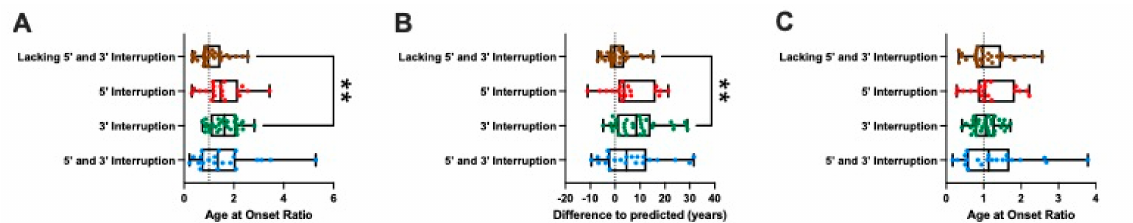
Figure 5. Interruption at the 3 (cid:48) end of the FXN GAA repeat tract is associated with a delayed age at disease onset. ( A ) Box-and-whisker plot showing the age at onset ratio (Actual/Predicted) when using the model of the subgroup lacking interruptions to predict age at onset for all members of the cohort. Kruskal–Wallis and subsequent Dunn’s multiple comparisons tests show that the 3 (cid:48) interruption subgroup had significantly greater age at onset ratios compared to the subgroup lacking 5 (cid:48) and 3 (cid:48) interruptions. ( B ) Box-and-whisker plot showing the differences in actual to predicted ages at onset for all members of the cohort when using the model lacking interruptions to predict age at onset. Kruskal–Wallis and subsequent Dunn’s multiple comparisons tests show that the 3 (cid:48) interruption subgroup has significantly later ages at disease onset compared to the subgroup lacking 5 (cid:48) and 3 (cid:48) interruptions. Patients with a 3 (cid:48) interruption present with FRDA approximately 9 years later than predicted on average compared to those lacking interruptions, based on the prediction model for individuals lacking 5 (cid:48) and 3 (cid:48) interruptions. ( C ) Box-and whisker plot showing the age at onset ratio when using subgroup-specific models, which shows that these models more accurately predict age at onset. There is no longer a significant difference between the 3 (cid:48) interruption subgroup and that lacking 5 (cid:48) and 3 (cid:48) interruptions. The whiskers indicate the minimum and maximum values whilst the box shows the 25th to 75th percentiles of the data with a line indicating the median. The dotted line indicates an age at onset ratio of 1 or a difference to predicted age at onset of 0. ** p ≤